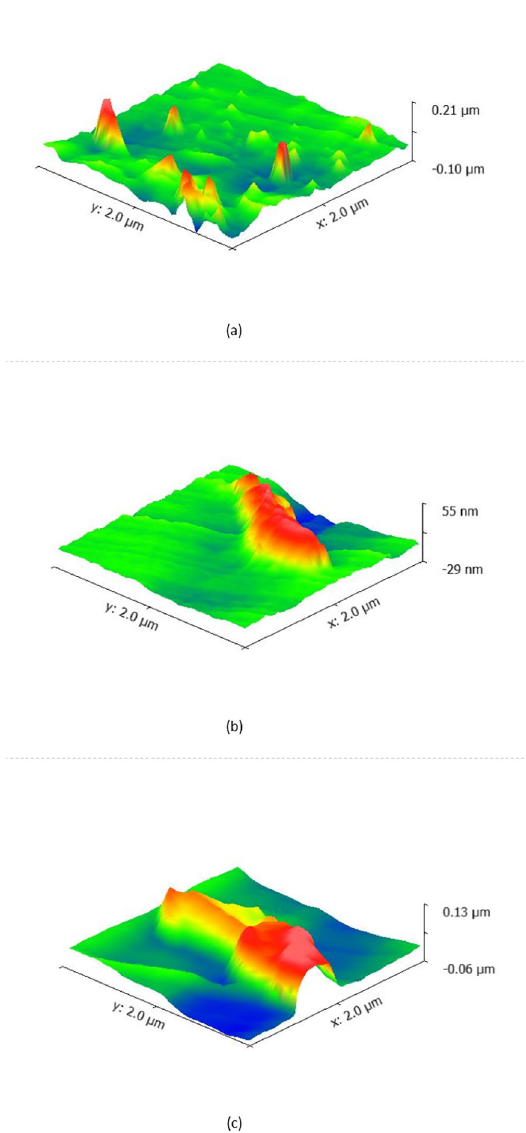
Figure 4. AFM Observations. (a) 0.075 wt.% CNT; (b) 0.15 wt.% CNT; (c) 0.30 wt.% CNT;